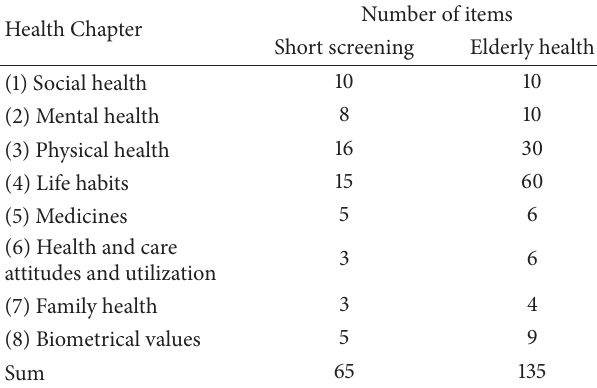
Table 1: Health chapters and number of items in them in short screening and elderly health versions of